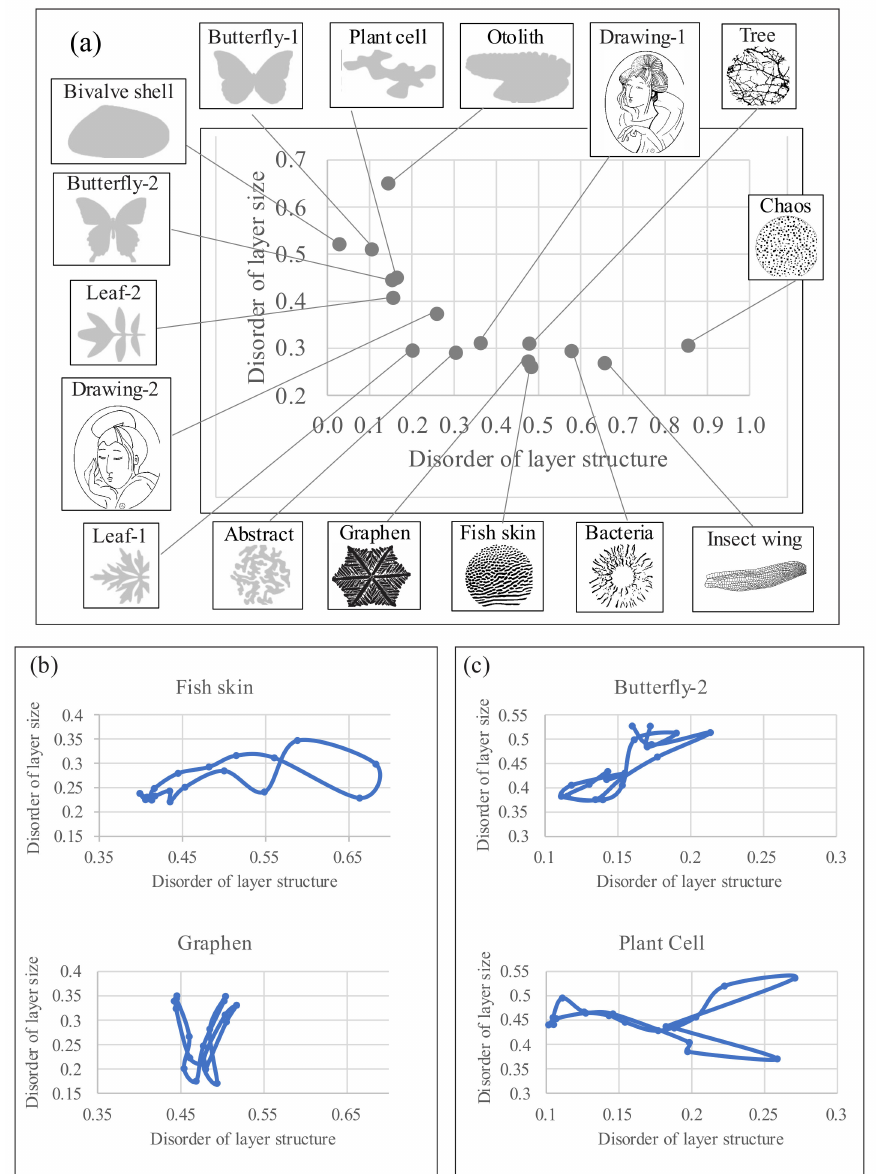
Figure 8. Morphological characteristics of arbitrary patterns. ( a ) Disorder of layer structure (DStr) and size (DSize) of sixteen arbitrary patterns. ( b , c ) Trajectory changes of DStr and DSize with